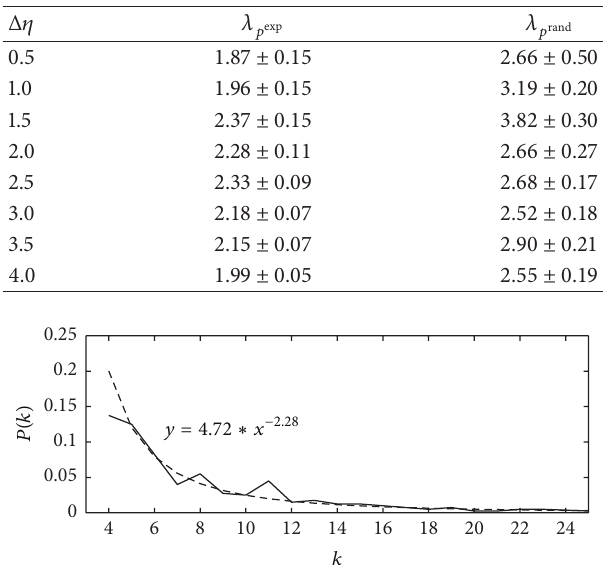
Figure 2: 𝑘 versus 𝑃(𝑘) plot for the Visibility Graph created for a test dataset of void probability distribution.